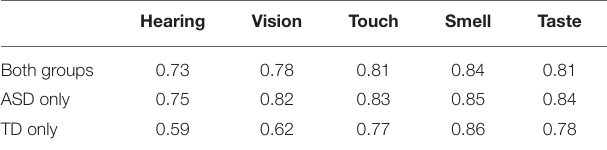
TABLE 2 | Factor loadings of sensory sub-scales on PCA factor